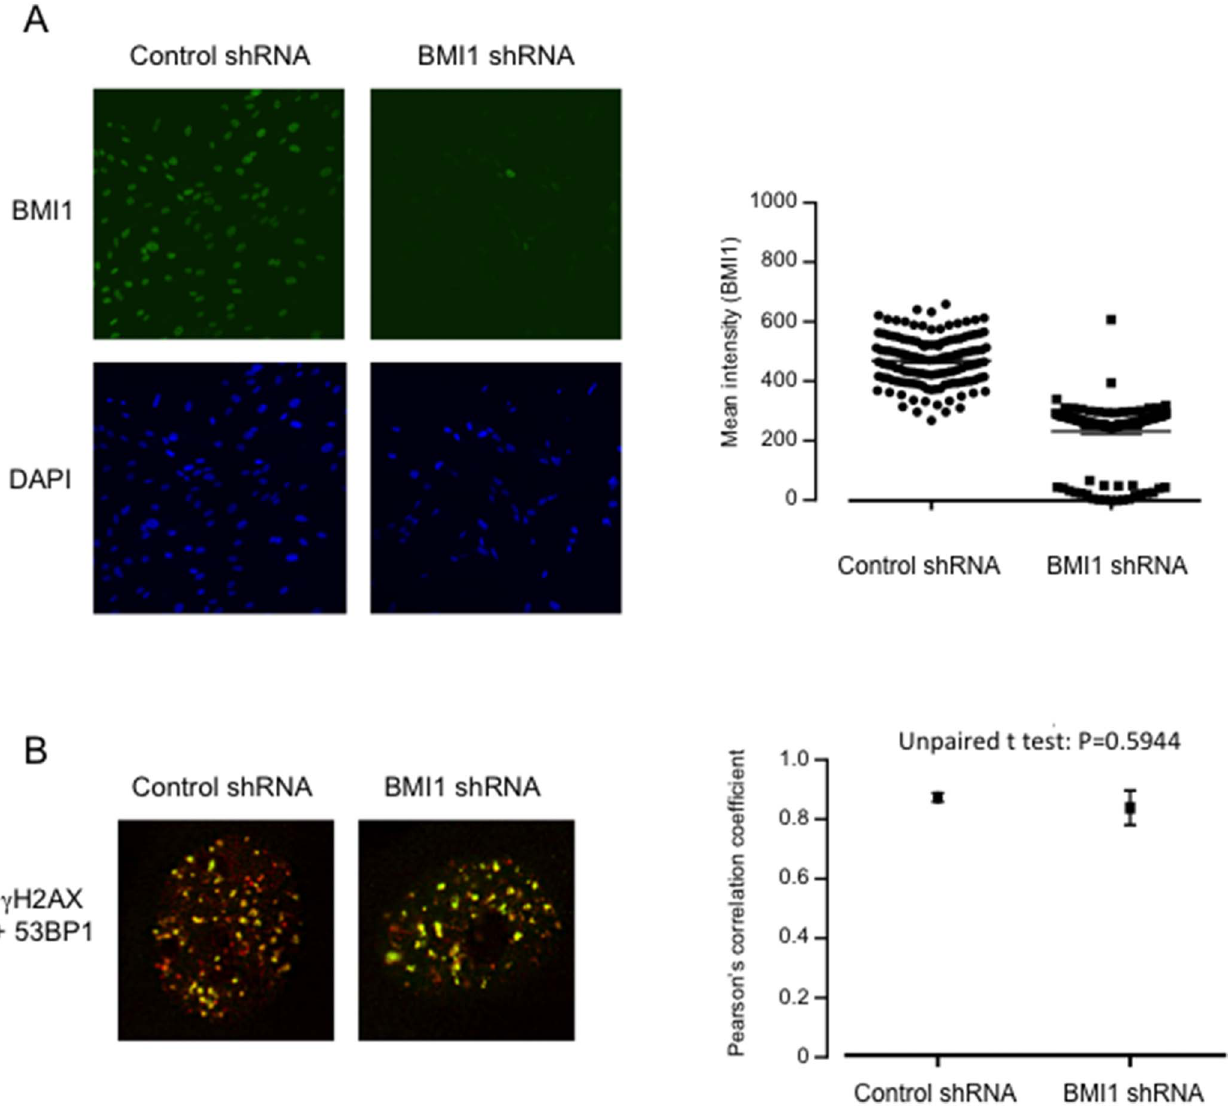
Figure 2. Visualizing Asi SI-induced DNA damage foci following BMI1 depletion. A. Asi SI:ER-transduced Hs68 cells were infected with a lentiviral vector expressing an shRNA against BMI1, or a random control shRNA, and stained for BMI1 (green) or DAPI. The right panel shows quantification of the BMI1 staining intensity (voxels) in 20 representative nuclei. B. The cells were treated with OHT for 4 h, to activate Asi SI, and co- stained for c H2AX (red) and 53BP1 (green). The right panel shows Pearson’s correlation coefficient values for co-localization of c H2AX and 53BP1 with and without BMI1 depletion.